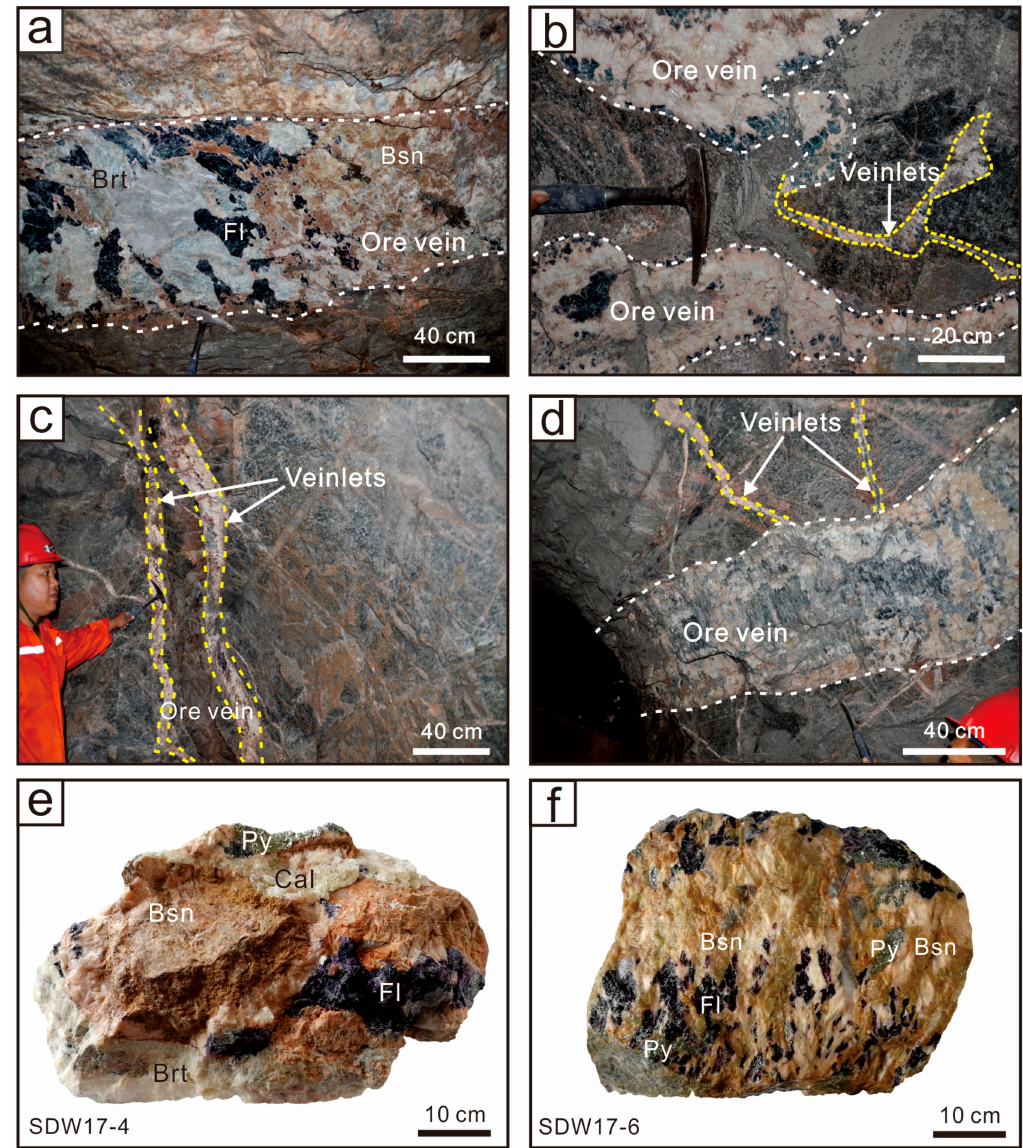
Figure 3. ( a – d ) Ore veins in the Weishan REE deposit; ( e ) hand specimen of a typical ore vein containing bastnäsite, barite, calcite, fluorite, quartz, and pyrite; ( f ) typical ore containing bastnäsite, calcite, fluorite, and pyrite. Bsn = bastnäsite; Brt = Barite; Cal = calcite; Fl = fluorite; Py = pyrite; Qtz =